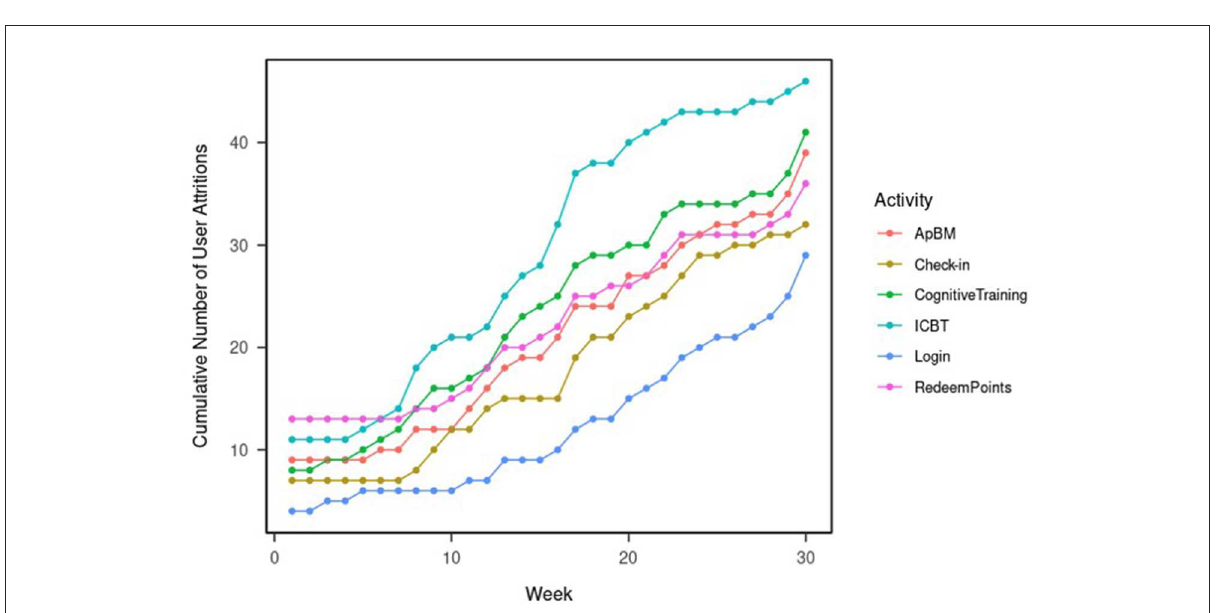
FIGURE2 User attritions in the DTx application.